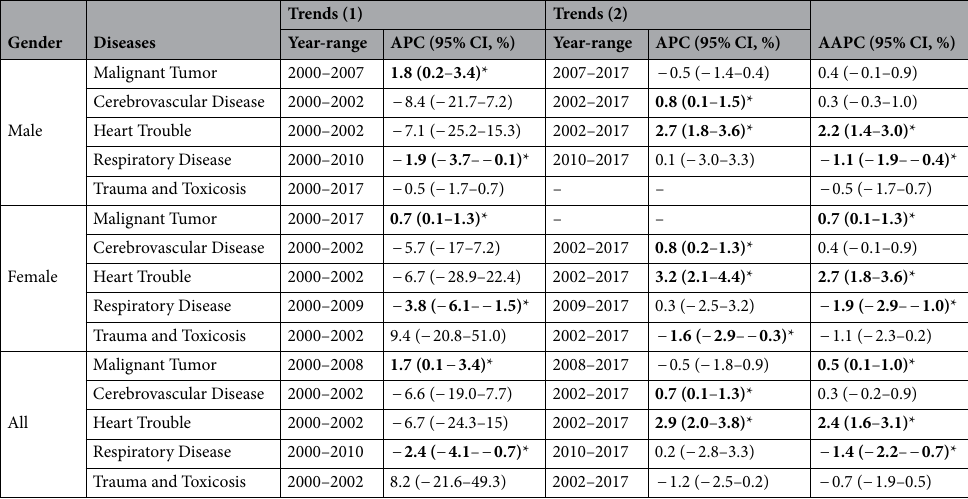
Table 1. The trends of the top 5 causes of death in urban areas of China from 2000 to 2017. APC Annual Percent Change; AAPC Average Annual Percent Change; CI confidence interval. Significant values are in bold. *Indicates that AAPC or APC is significantly different from zero at the alpha = 0.05